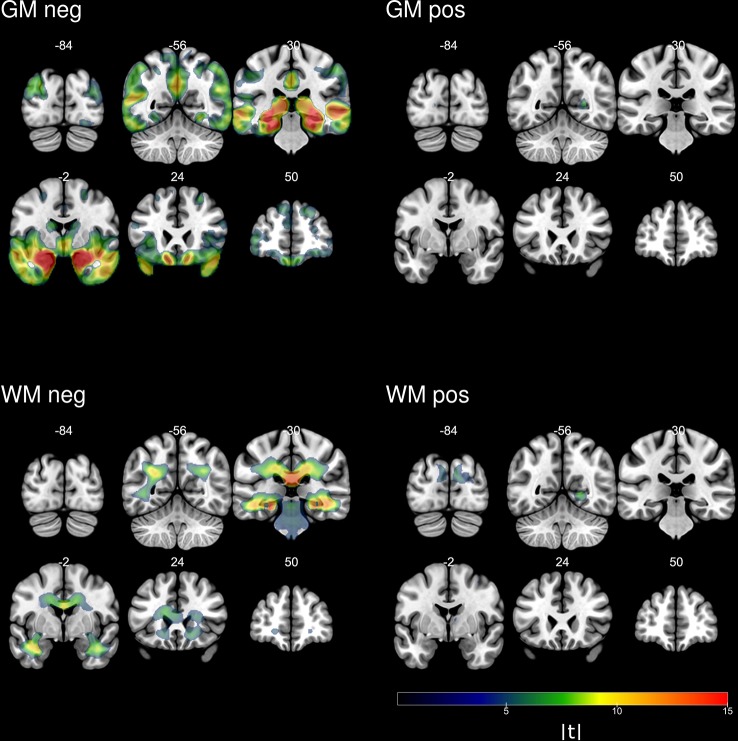
Absolute values of the t-statistics of voxel-based analyses of the AD score in SHIP-Trend.